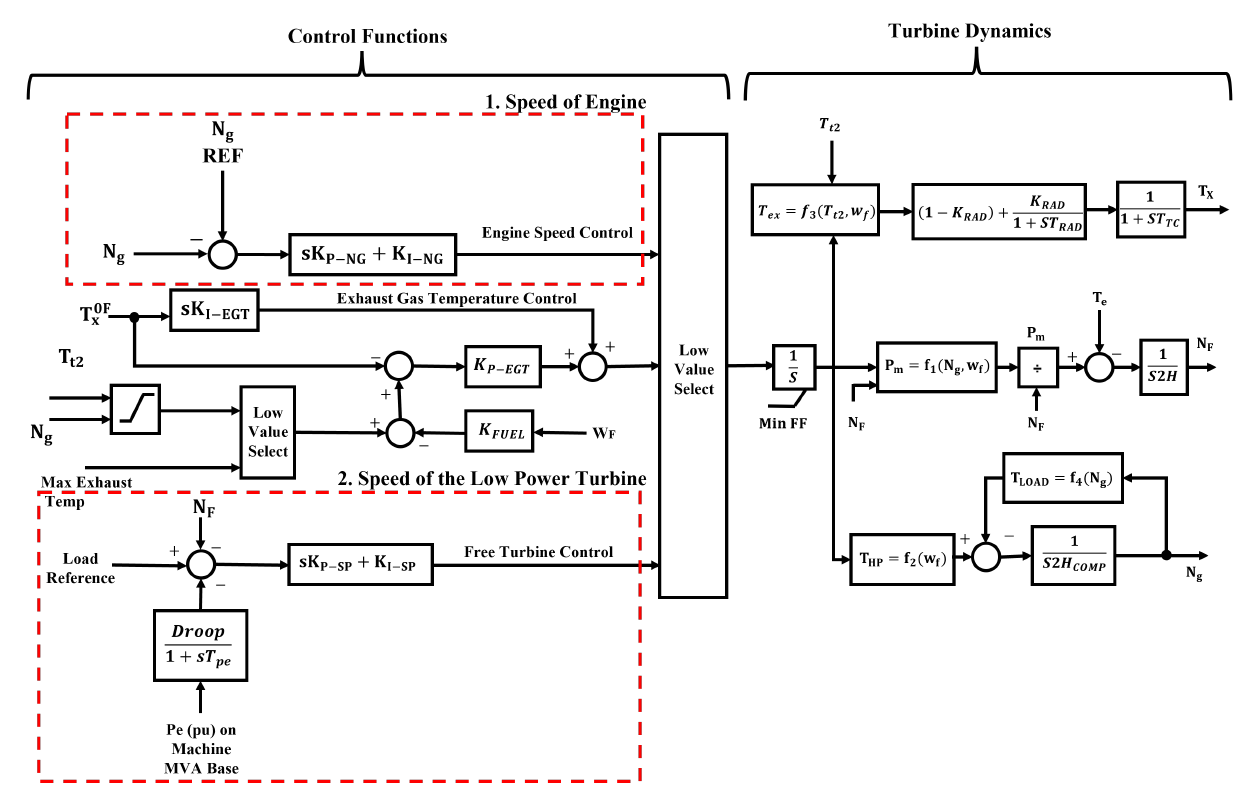
Figure 9. Aero-derivative model